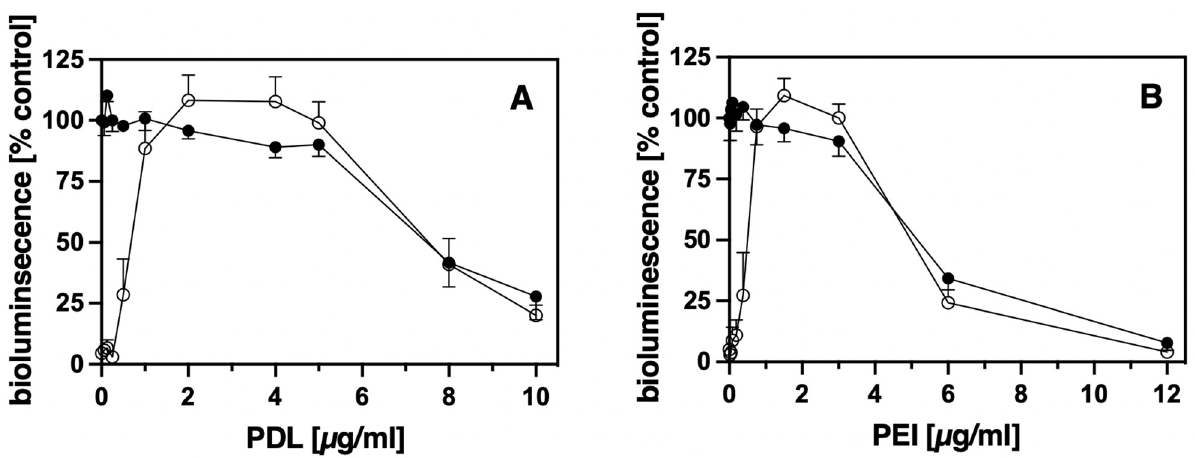
Fig 3. Direct addition of PDL and PEI to the medium results in strong cell adherence. HEK 293 cells expressing either GRPR55- or B 2 R R128A-RlucII constructs were seeded in complete medium with the addition of increasing concentrations of PDL (A) or PEI (B) as indicated. After 2–3 d strength of cell attachment was estimated as described in the legend of Fig 2. ( ● ) control, ( � ) rinsed, symbols represent Mean ± SEM (n = 4, performed in duplicates). The wells without addition of cationic polymer and without rinsing were taken as 100%.